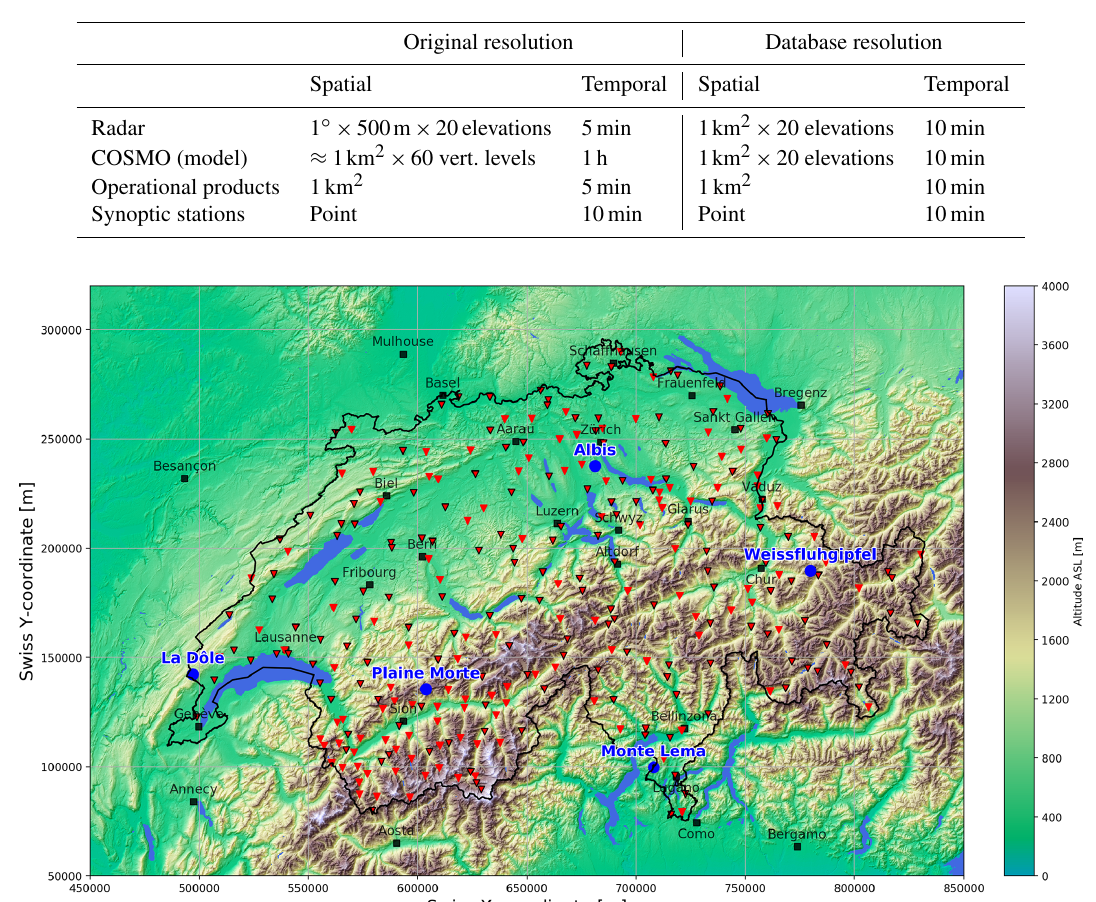
Table 1. Native and transformed spatial and temporal resolutions of the products included in the gauge–radar database.